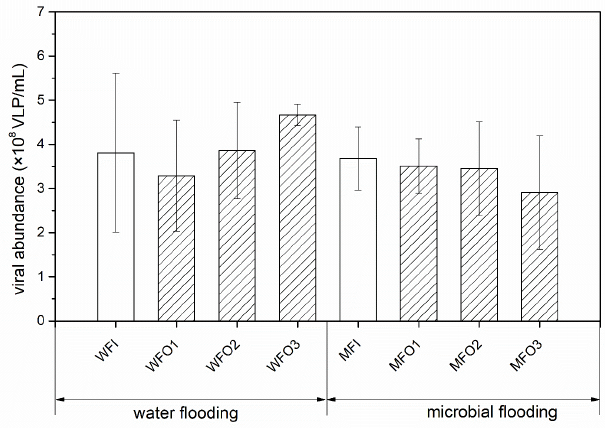
Figure 2. Viral abundances in production fluids from Daqing oilfield. The bars with slash represent production wells, and bars without slash represent the injection well.